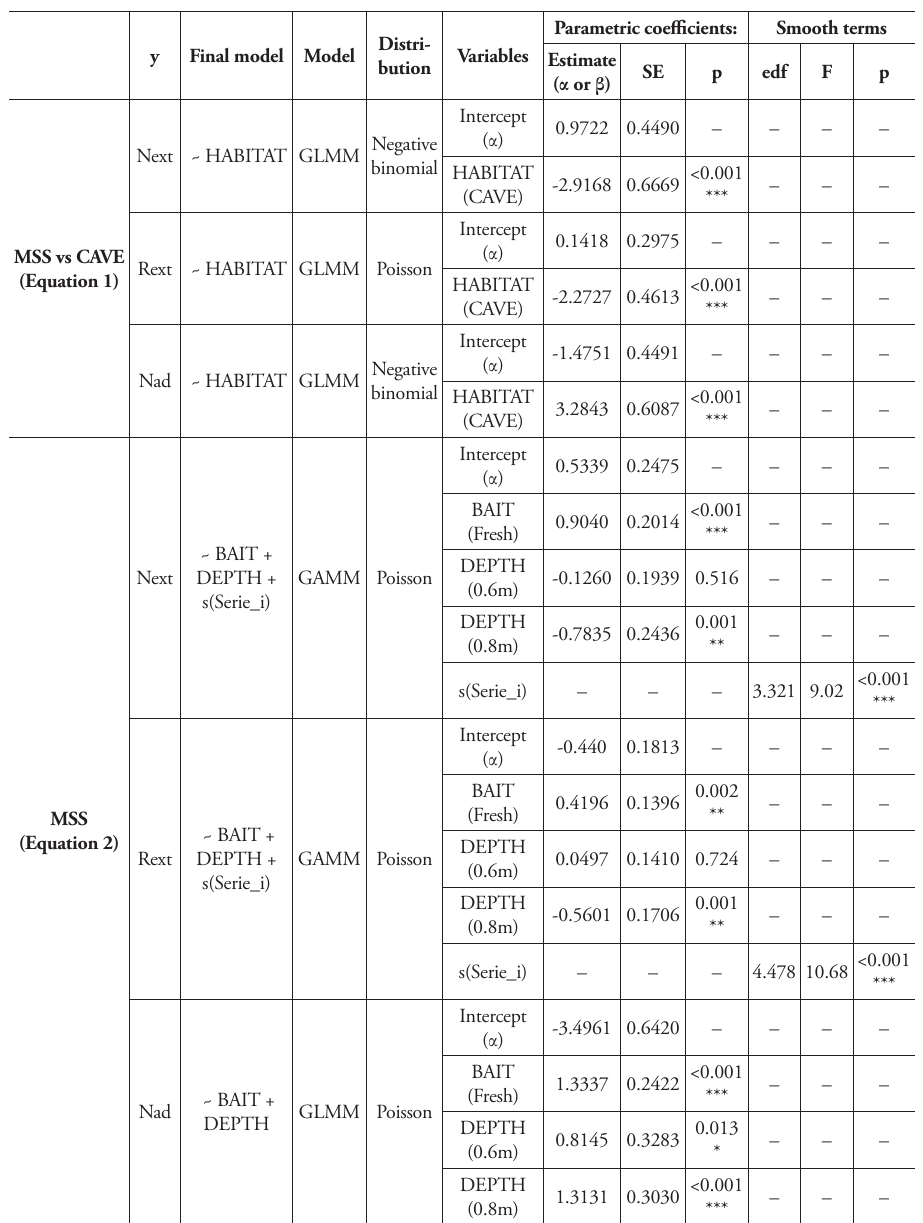
Table 1. Estimated regression parameters and approximate significance of smooth terms according to GLMMs and GAMMs, respectively, obtained from the 3 sets of models and the 3 dependent variables considered (Next, Rext, Nad, see text). The final model structures resulting from model selection are reported (only fixed terms are